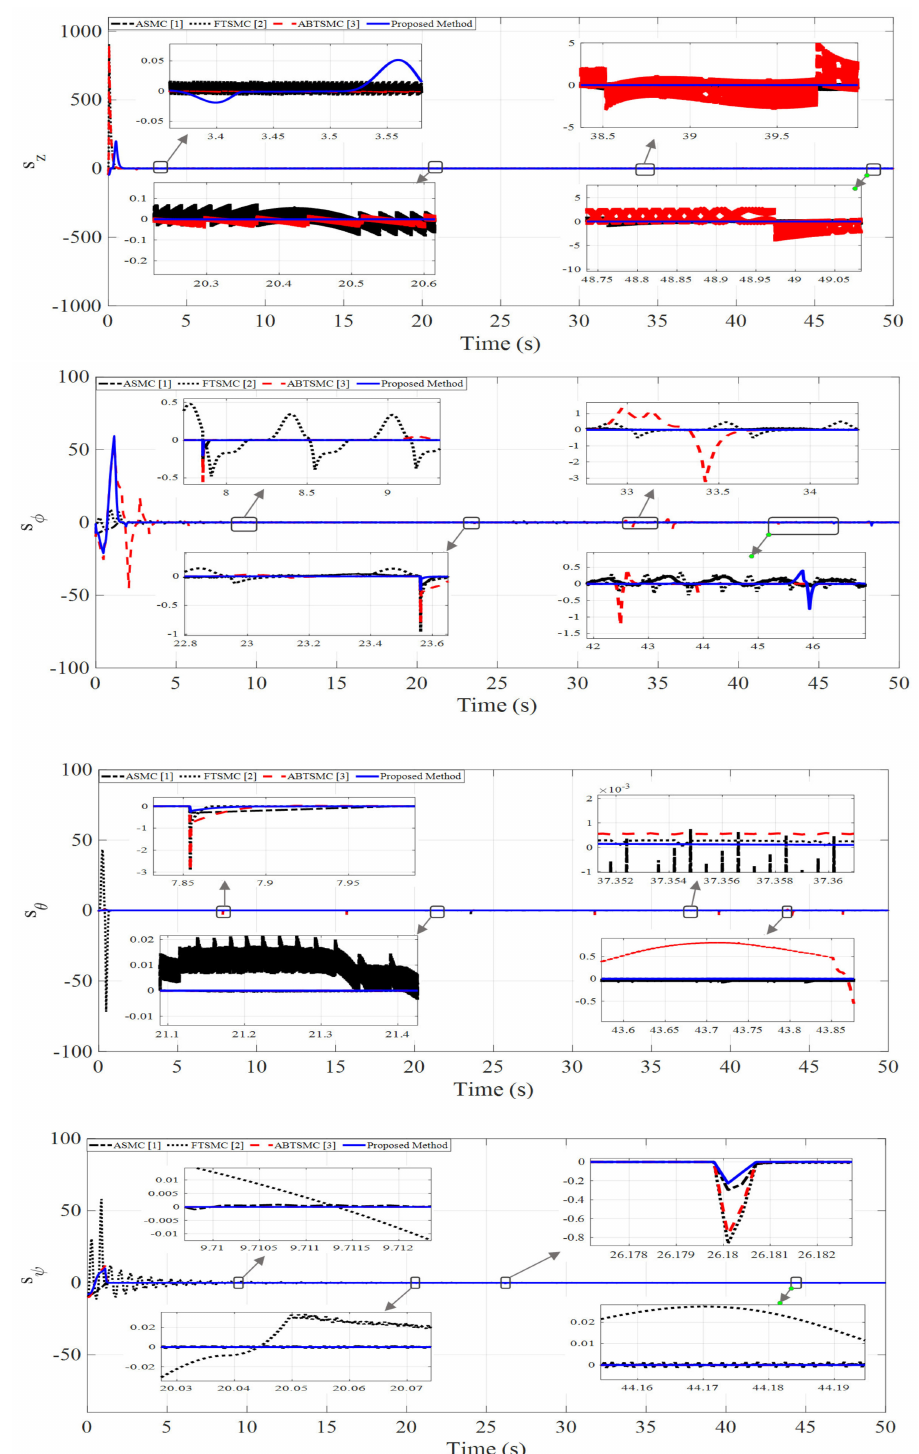
Figure 5. Sliding surface under 50% step fault in actuators 1 and